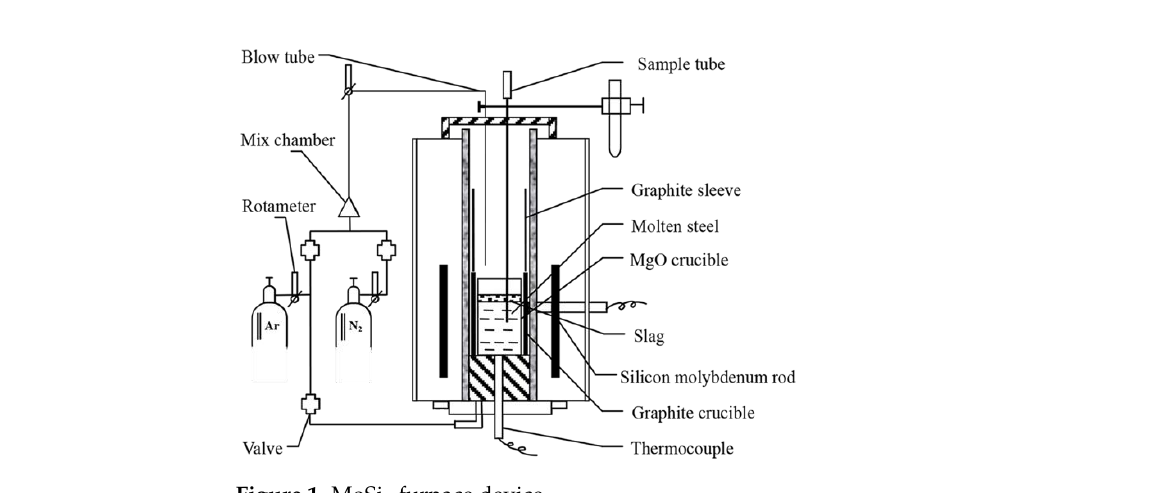
Figure 1. MoSi 2 furnace device. Table 1. Compositions of designed slag, mass%.